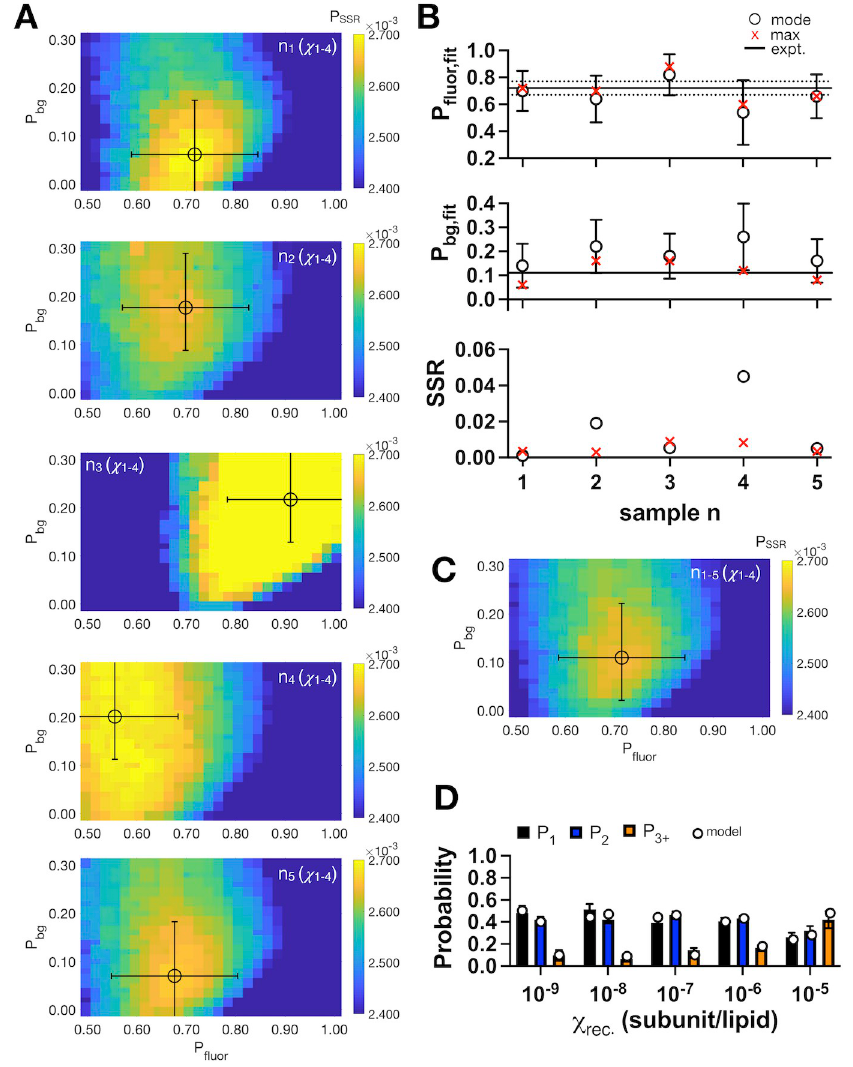
Fig 3. Single-molecule photobleaching estimation of fluorophore labeling recapitulates sample variability. (A) over the parameter space of ( P , P ) for different experimental samples, n , of the covalently cross- Heatmap of P SSR fluor bg linked R230C/L249C CLC-ec1 dimer. The circle and error bars reflect the mode ± σ from the bootstrapping analysis. (B) The maximum and mode values of P and P , along with SSR compared to the experimental values, dotted line. fluor bg (C) Global fit of ( P , P ) obtained from pooling experimental data for samples n = 1–5. (D) Experimental fluor bg photobleaching data ( P 1 , P 2 , P 3+ ), along with the modeled probability distribution (circles) using ( P fluor , P bg ) = (0.72,0.10) corresponding to the maximum value from the global fit in panel (C).